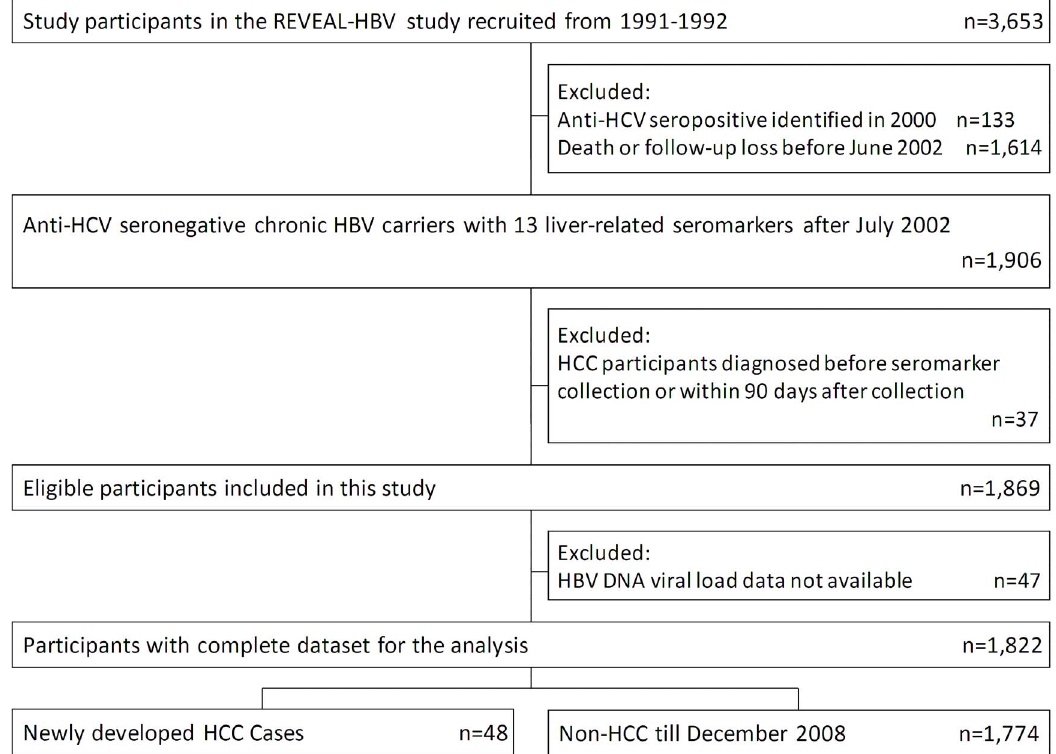
Figure 1. Flowchart of study participants selected from original REVEAL-HBV cohort and included in this analysis.